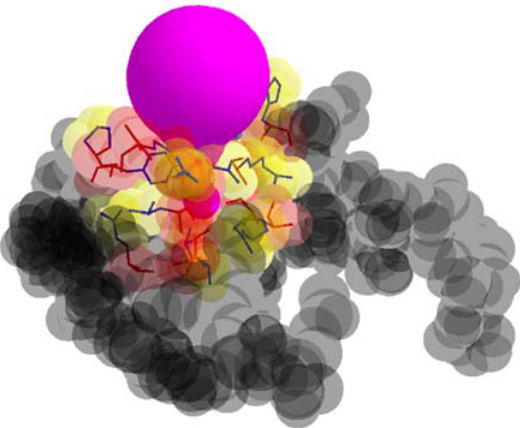
Figure 3. A tunnel (color purple), tunnel adjacent amino acids, and remaining amino acids (color gray).